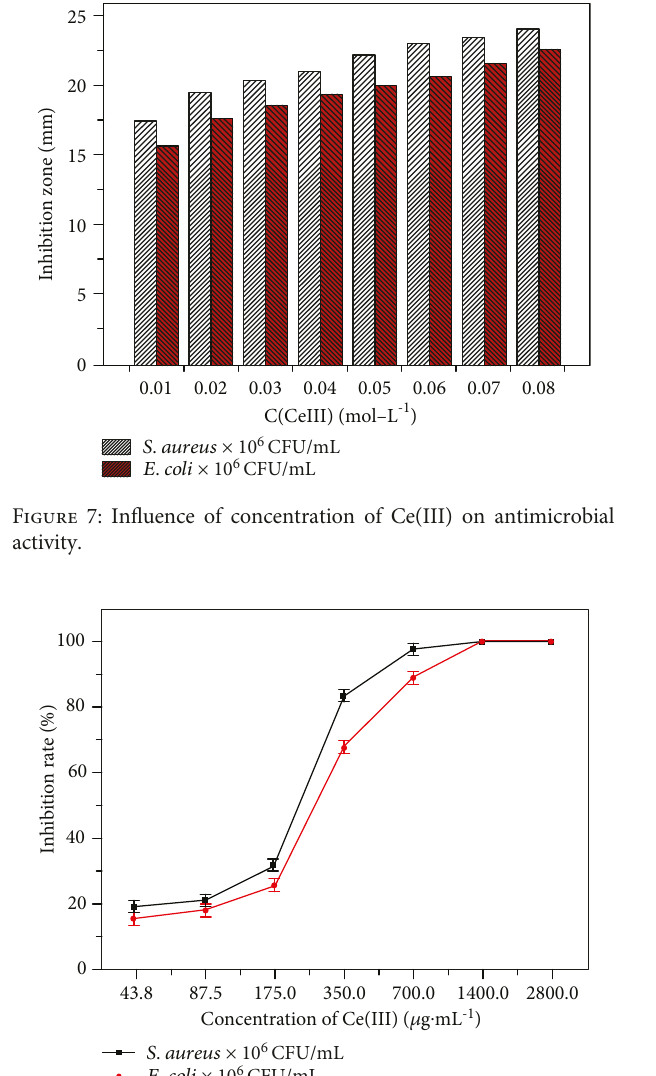
Table 3: Color test results of the ink after centrifugation.